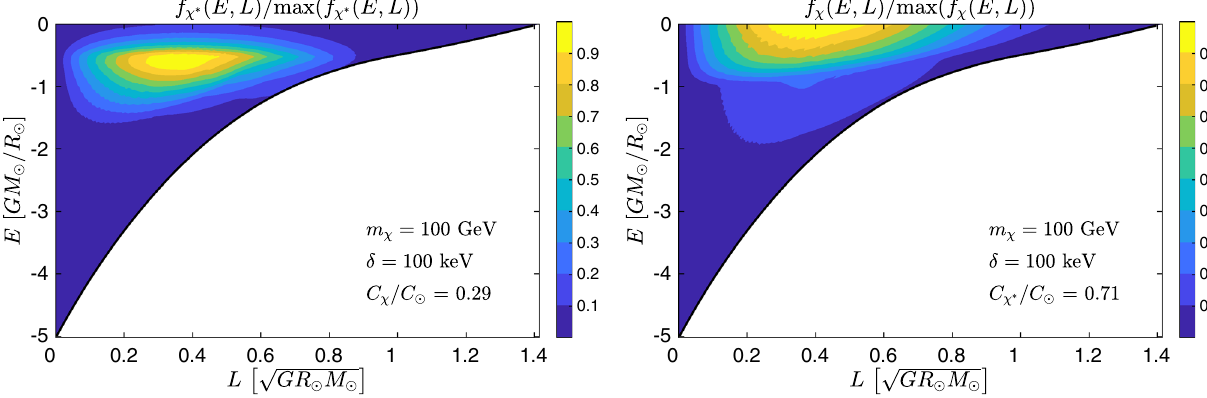
Fig. 2 Thedensityofdarkmattercaptureinthe E - L plane.Inelasticscatteringisassumed,with m χ = 100GeVand δ = 100keV.Thedistributions are normalized by their own largest value. Left panel: Capture of halo χ particles. Right panel: Capture of halo χ ∗